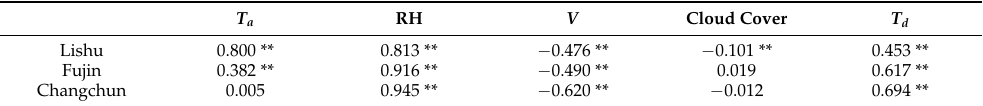
Table 3. Correlation coefficients between the dew intensity and meteorological factors in Lishu, Fujin and